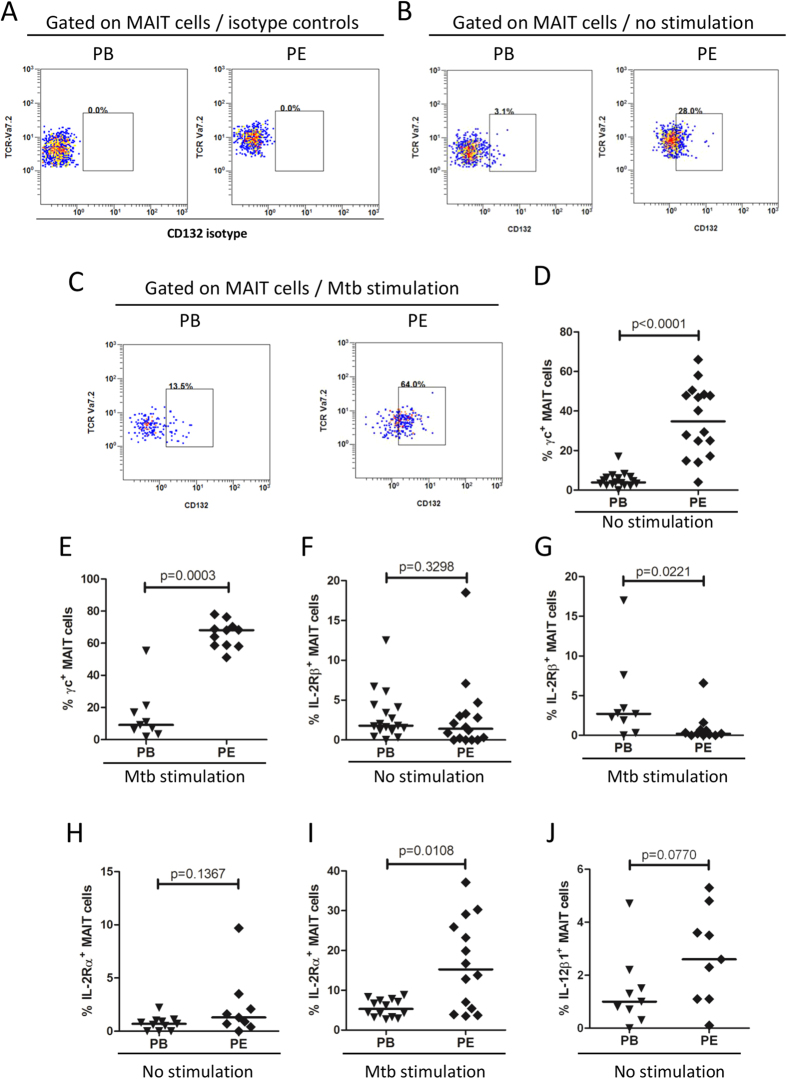
IL-2 and IL-12 receptor expression on MAIT cells from peripheral blood and tuberculous pleural effusions.(A) Representative flow plots showing γc (CD132) isotype control antibody staining of MAIT cells from peripheral blood (PB) and tuberculous pleural effusion (PE). (B) Representative flow plots showing expression of γc receptor (CD132) on MAIT cells in the absent of antigen stimulation. (C) Representative flow plots showing expression of γc receptor (CD132) on Mtb-stimulated MAIT cells from peripheral blood (PB) and tuberculous pleural effusion (PE). (D–E) MAIT cells from tuberculous pleural effusions exhibited significantly higher expression of γc receptor (CD132) than those from peripheral blood both in the absent of antigen stimulation (D) and after Mtb stimulation (E). (F–G) The expression of IL-2Rβ on MAIT cells in the absent of antigen stimulation (F) or after Mtb stimulation (G). (H–I) The expression of IL-2Rα on MAIT cells in the absent of antigen stimulation (H) or after Mtb stimulation (I). (J) The expression of IL-12Rβ1 on MAIT cells in the absent of antigen stimulation. Horizontal bars in the scatter plots indicate medians. The nonparametric Mann-Whitney test was used for statistical analysis between groups.